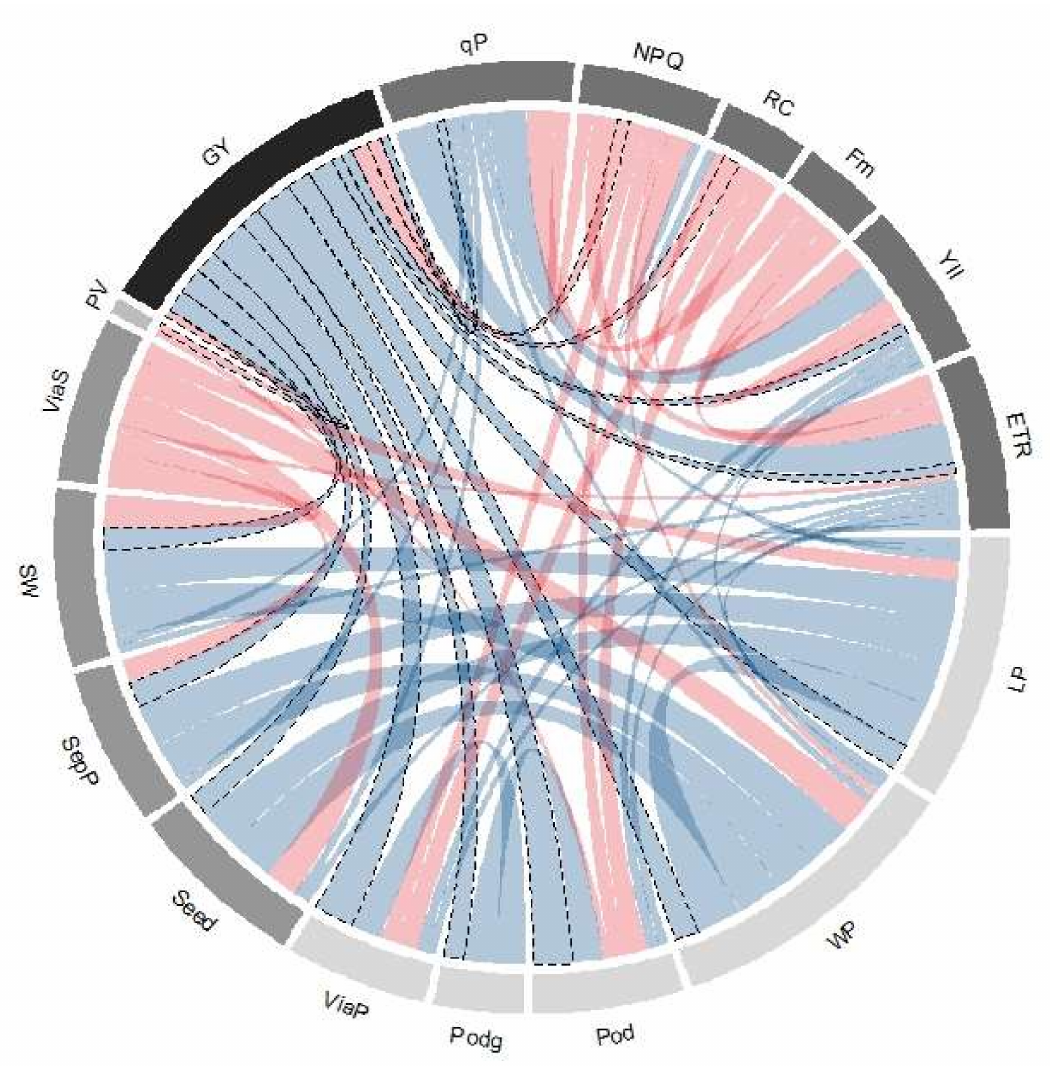
Figure 7. Chord diagram of correlation coefficients between agronomic, phenological and physiolog- ical variables the tepary bean genetic resource. Ribbons inside the circle correspond to significant correlations with a p -value < 0.05; blue ribbons indicate positive coefficients and red ribbons indicate negative coefficients. Width of pods (WP), length of pods (LP), pods mass (Podg), viability of pods (ViaP), seeds per pod (SepP), weight (g) of 100 seeds (SW), viability of seeds in the pod (ViaP), pollen viability (PV), grain yield (GY), photochemical pathway (qP), fraction dissipated as heat (NPQ), relative chlorophyll (RC), maximum fluorescence level (F m ), photochemical yield (Y(II)), and electron transport rate